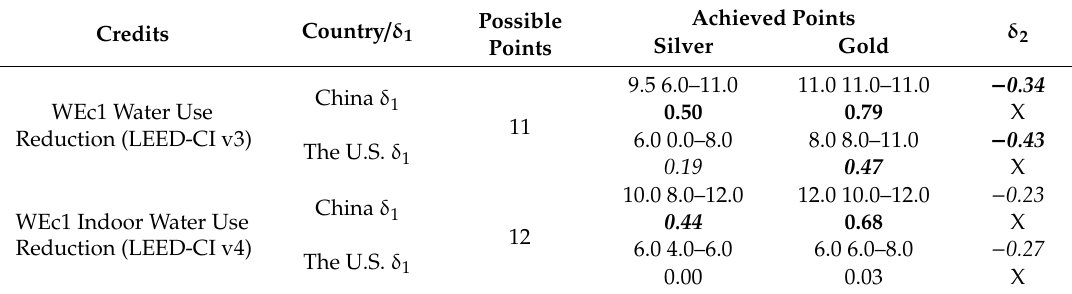
Table 4. LEED-CI v3 and v4 Indoor Water Use Reduction (WEc1) credits category: The median